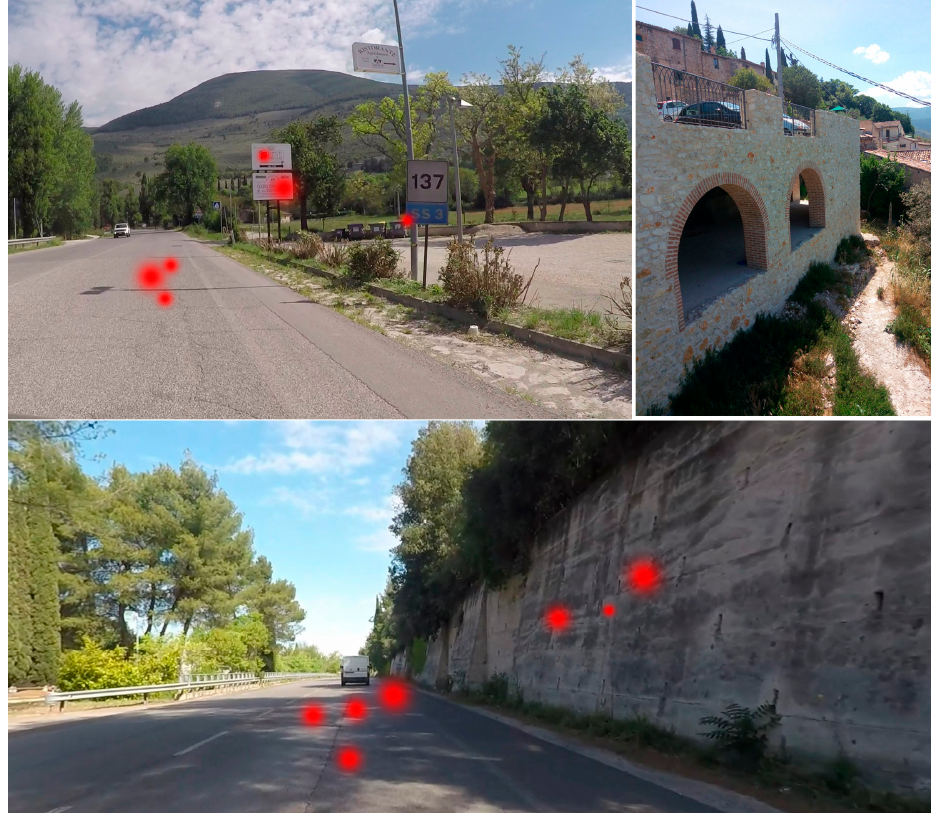
Figure 6. Landscape visual